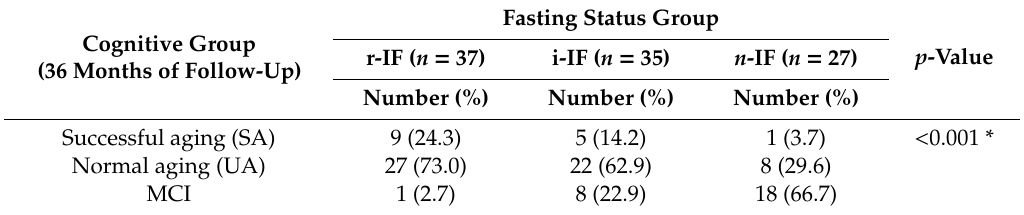
Table 3. Cognitive changes after 36 months follow-up ( n =